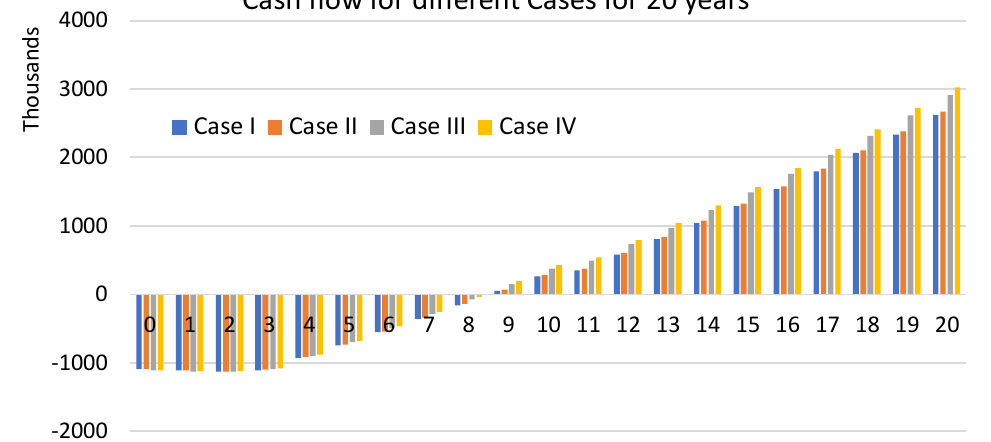
Figure 9. The average annual energy cost per dwelling with and without VPP (AUD).